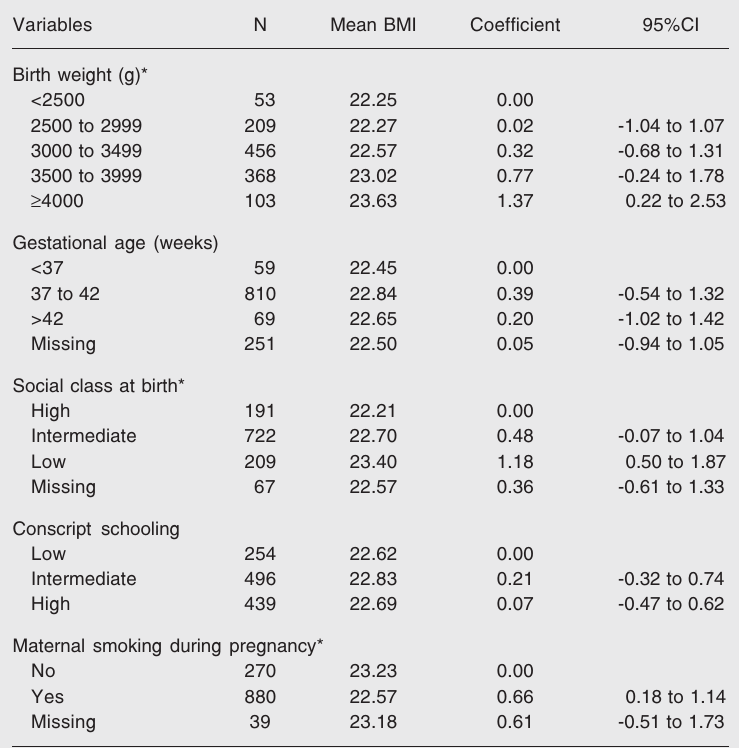
Table 1. Body mass index according to birth weight, gestational age, social class at birth, conscript schooling, and maternal smoking during pregnancy (Ribeirão Preto birth cohort study 1978/79) (N = 1189 adolescent males).